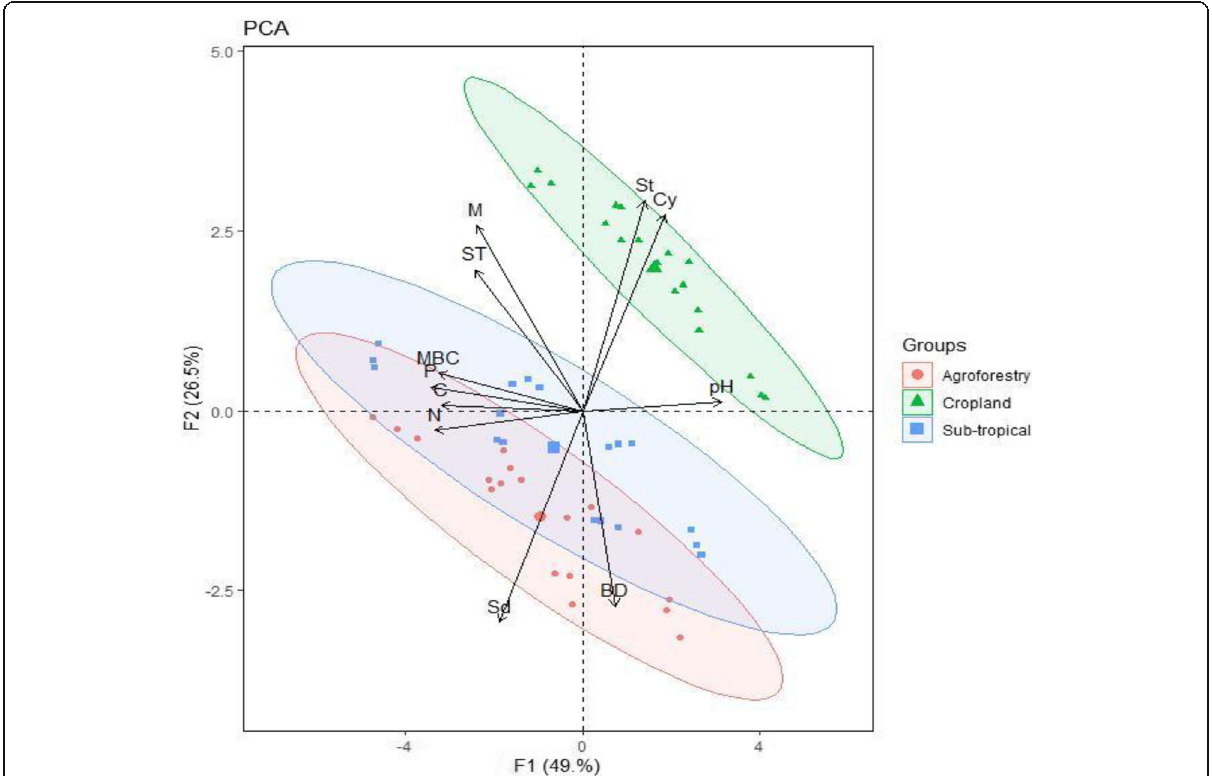
Fig. 4 Principal component analysis (PCA) of soil parameters in the three land-use